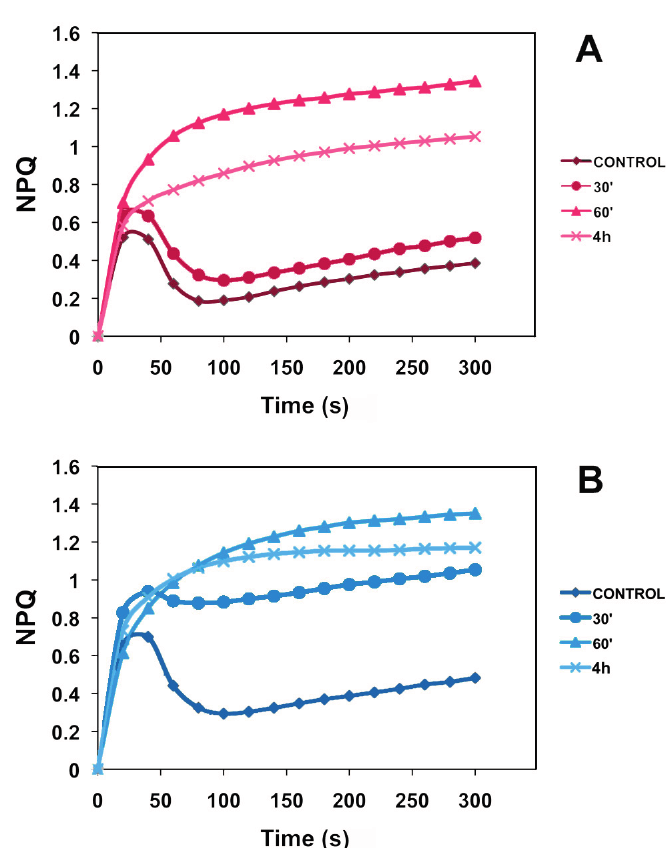
Figure 2. Kinetics of NPQ formation in A. thaliana young ( A ) and mature ( B ) leaves, during a 5-min actinic illumination with 120 μ mol photons·m − 2 ·s − 1 , of control